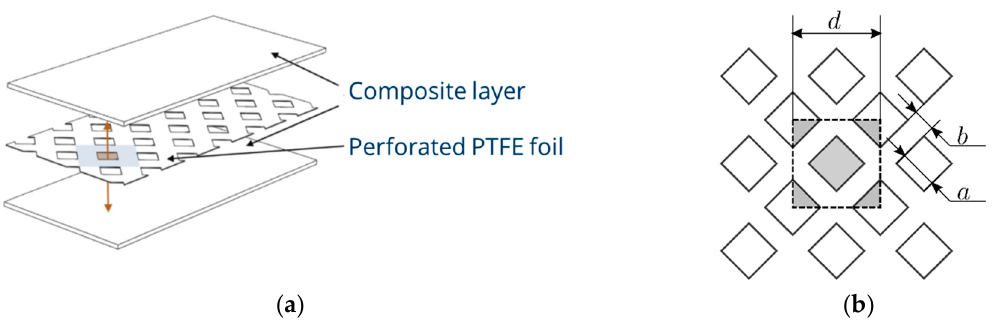
Figure 1. Modification concept. ( a ) Interface modification concept by inter-leaved perforated PTFE foils with quadratic holes; ( b ) geometry parameters of perforated PTFE foil: a: edge length of hole, b : distance between holes, d : edge length of unit cell [13].